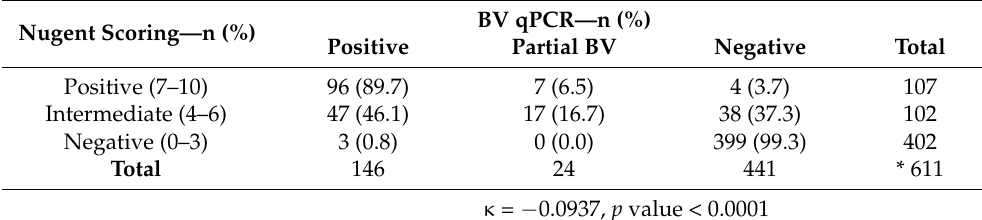
Table 2. Agreement between Nugent scoring and qPCR test results. The Cohen’s kappa coefficient ( κ ) was used to test the agreement between two different diagnostic methods for bacterial